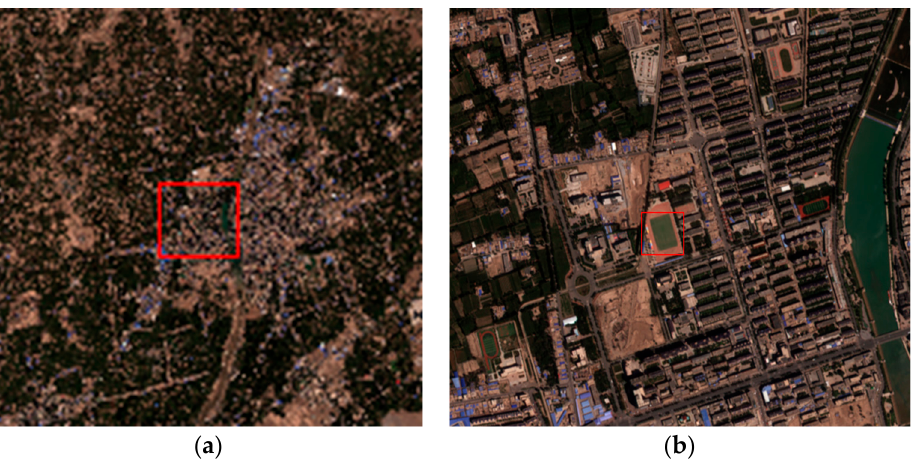
Figure 12. ( a ) Select Grassland area (in the red box) and its surrounding environment (urban background); ( b ) enlarged Grassland area (the area is about (63.57 × 112.09) m 2 ).